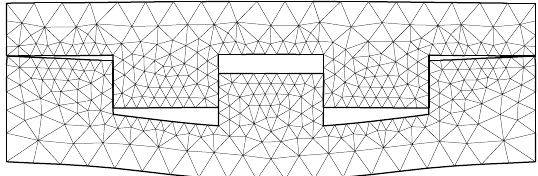
Figure 6.9 . Deformed configuration of the two viscoelastic bodies for µ = 1 . 0ns/m 2 and η = 0 . 4ns/m 2 .